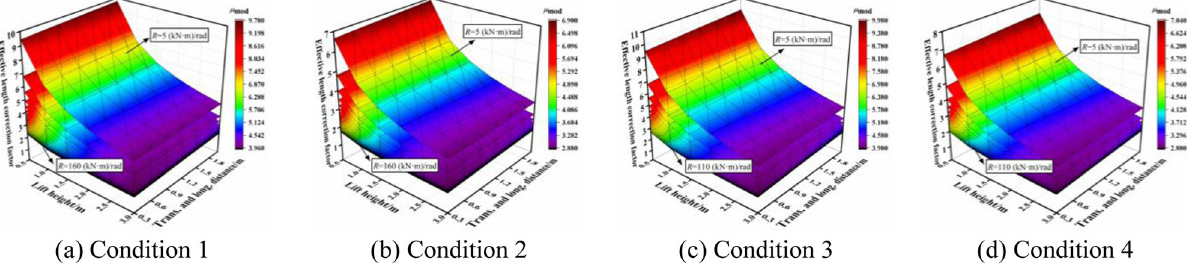
Fig 15. Effective length correction factor under different conditions. (a) Condition 1. (b) Condition 2. (c) Condition 3. (d) Condition 4.